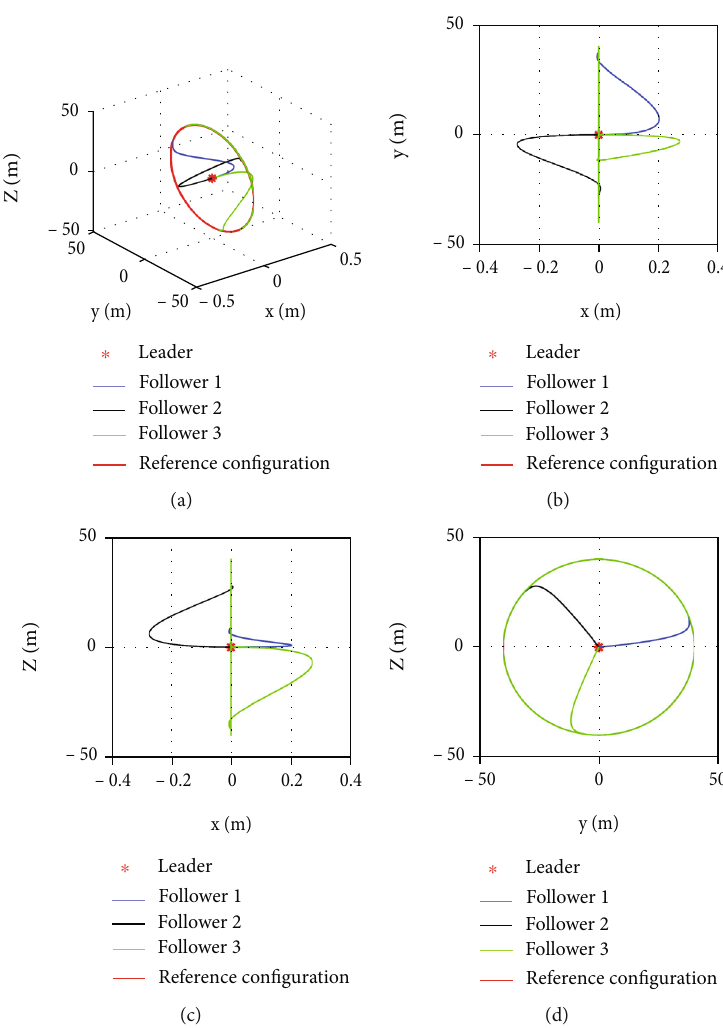
Figure 8: The trajectories of the followers relative to leader